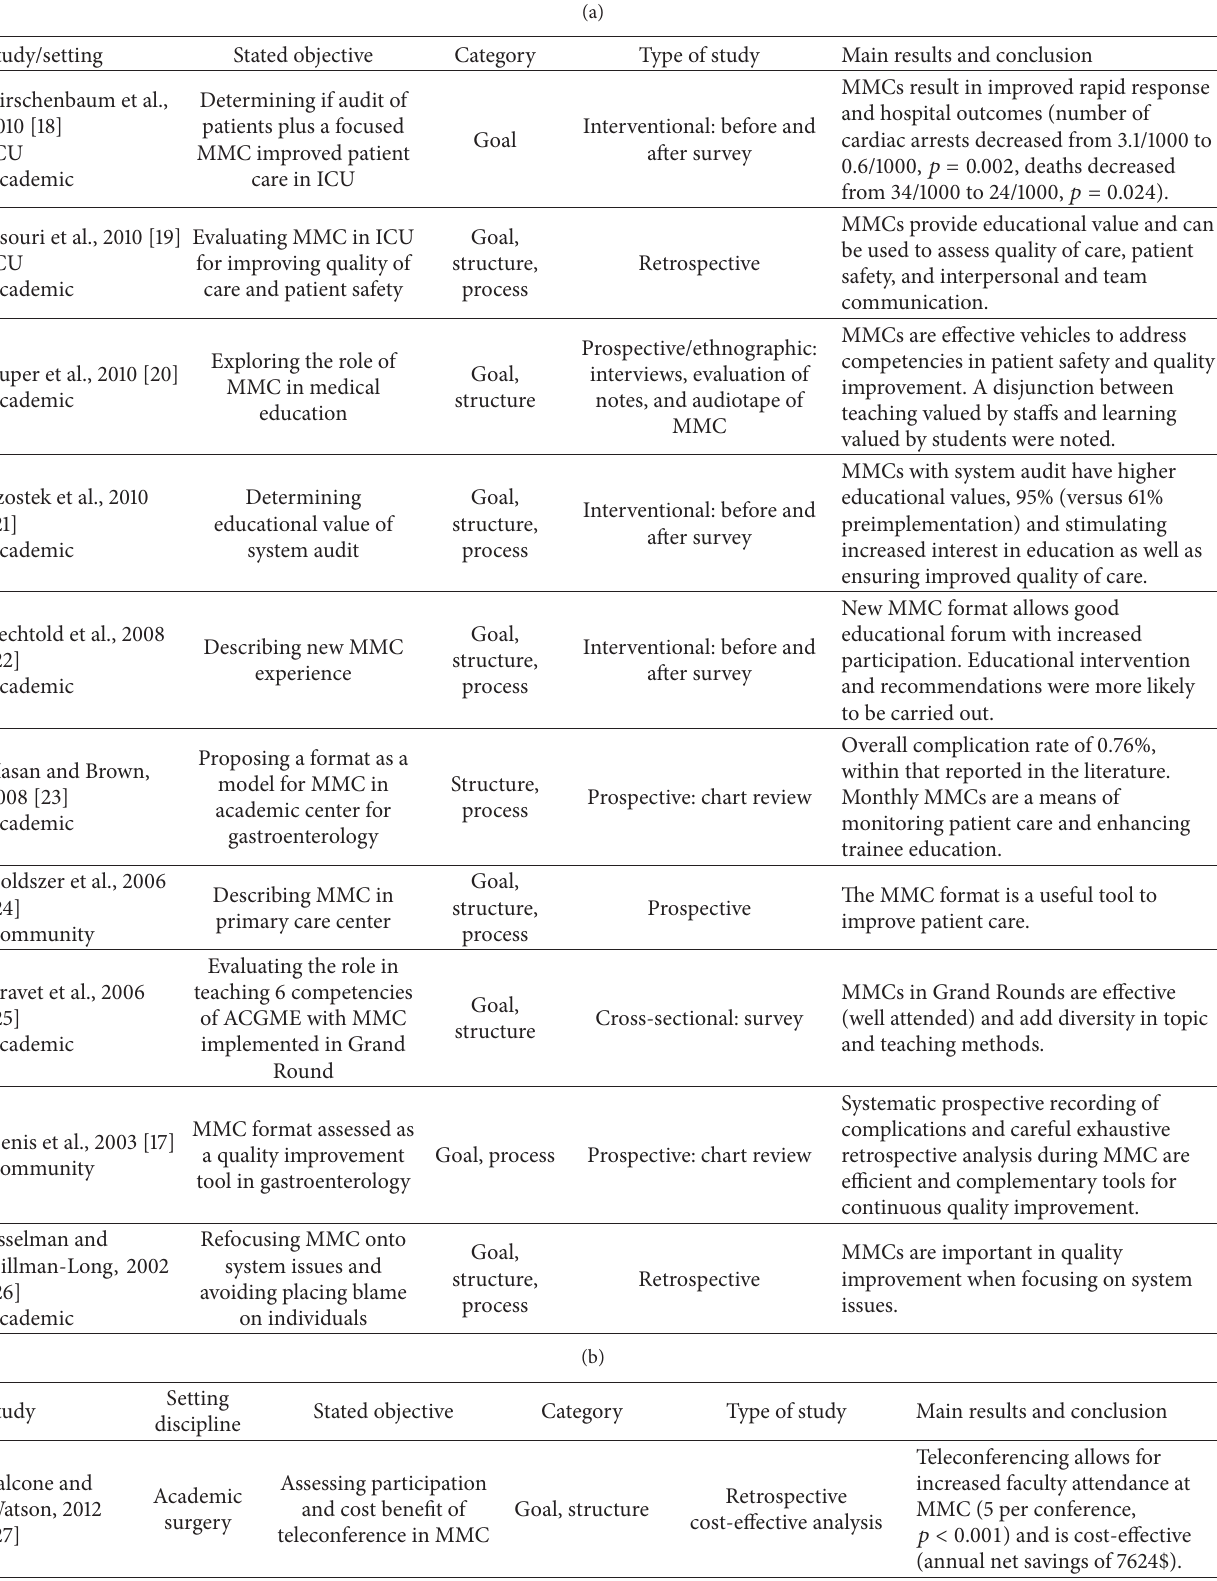
Table 1: (a) Articles for medicine and subspecialties, primary care, and ICU (10 articles). (b) Articles for surgery and its subspecialties, obstetrics, and anesthesia (25 articles). (c) Articles for both medicine and surgery (3